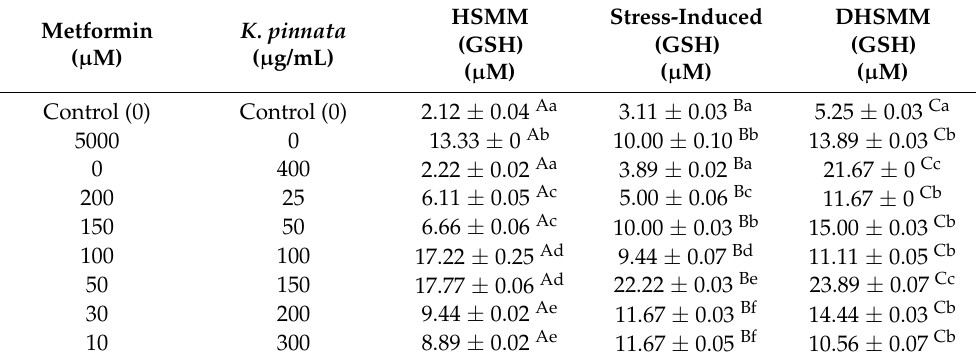
Table 6. Reduced glutathione content in cells after 72 h of treatment. Data are presented as mean ± standard error of the mean. Significant differences are indicated by different letters (upper- case letters within row; lowercase letter within column for each treatment option) according to Tukey post hoc test ( p < 0.05). Control (No treatment); Human skeletal muscle myoblast (HSMM); Diabetic human skeletal muscle myoblast (DHSMM).